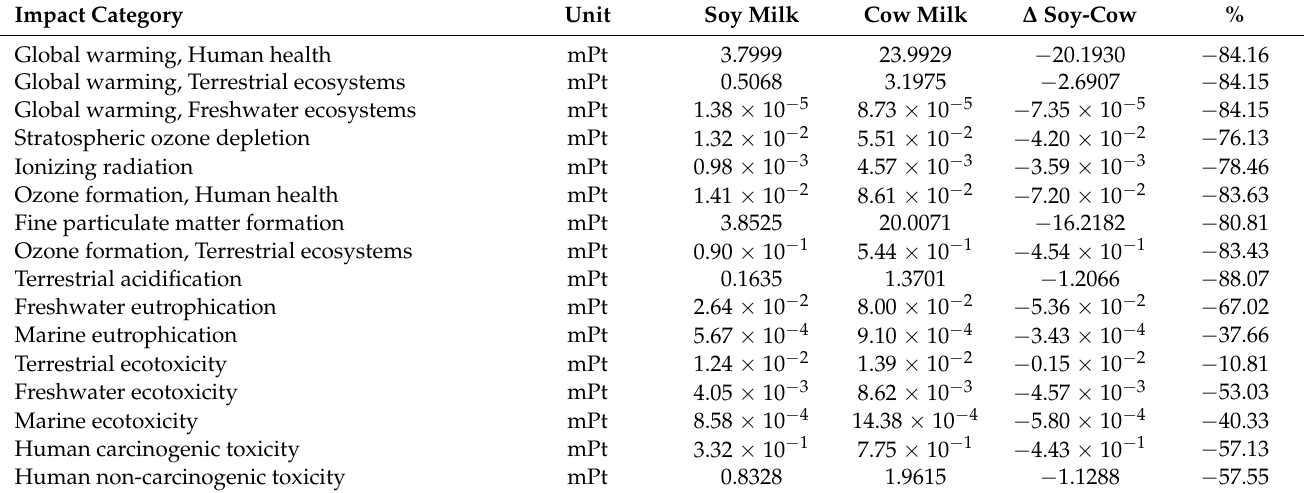
Table A4. Life Cycle Assessment Calculation (LCIA): comparison between Soy Milk and Cow Milk. Impact Categories and Damage Categories. Aggregated Weighted Average: total environmental load expressed as a Single Score (mPt = milliPoints).